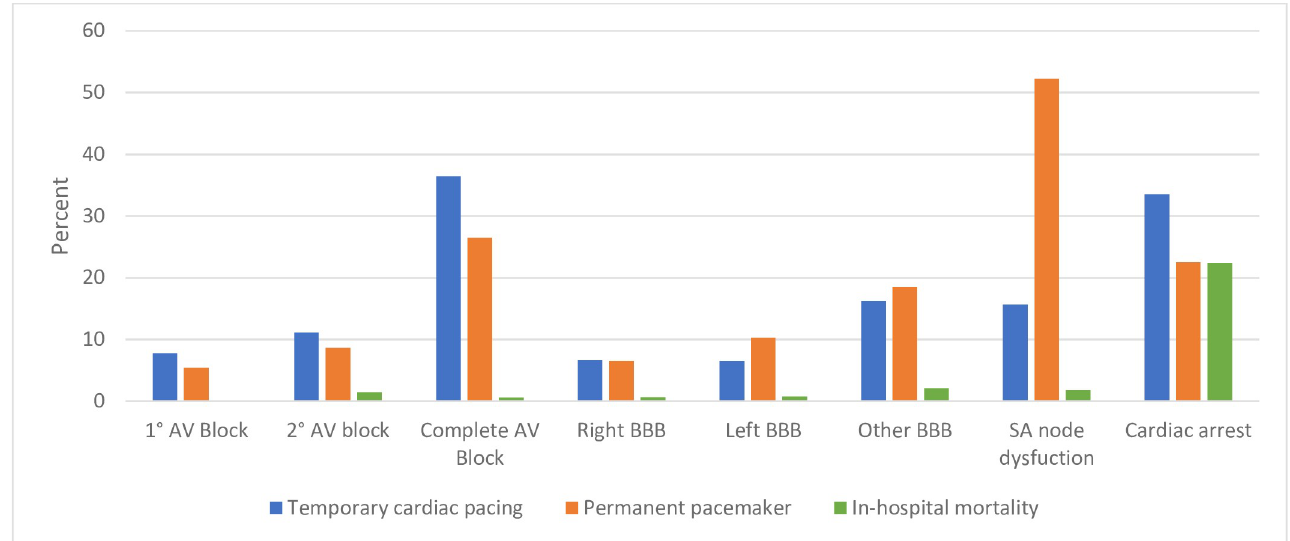
Fig 2. Pacemaker implant and mortality rates stratified by conduction disease. Bar graph displaying the rates of temporary/permanent pacemaker implant and in-hospital mortality for each type of heart rhythm disorder described in this study.